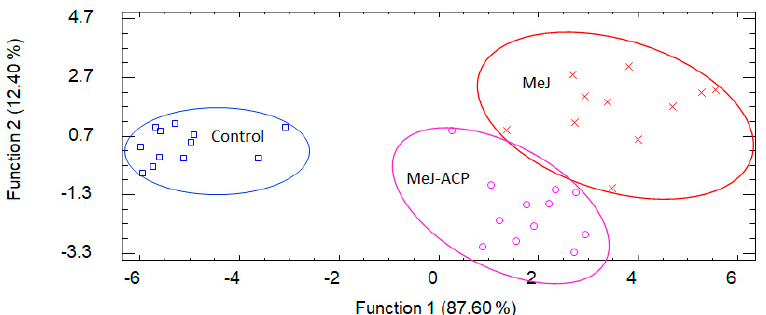
Figure 1. Distribution of samples (grapes and wines) in the coordinate system defined by the discriminant functions according to the treatments.